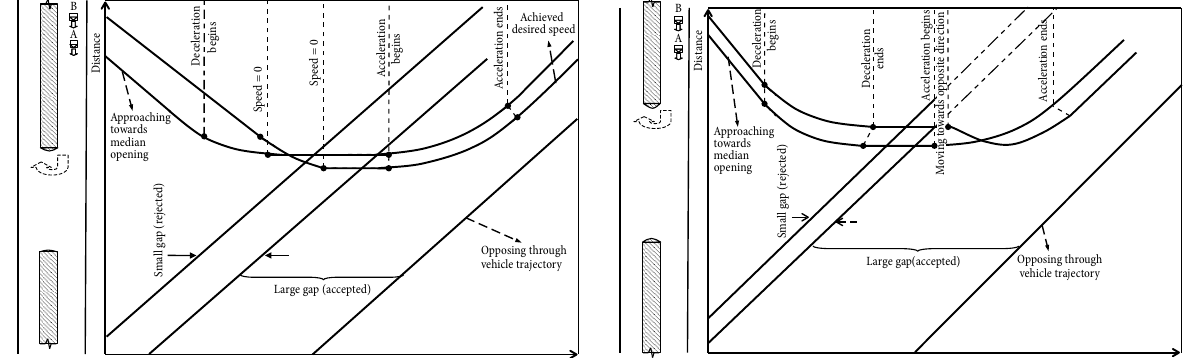
Fig. 5. Time–distance diagram for parallel SM Fig. 6. Time–distance diagram for stream lined SM